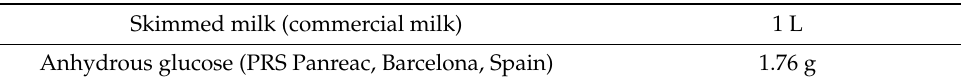
Table 2. Composition of sperm-freezing extender for skimmed milk (fraction A) for a total volume of 1 L.